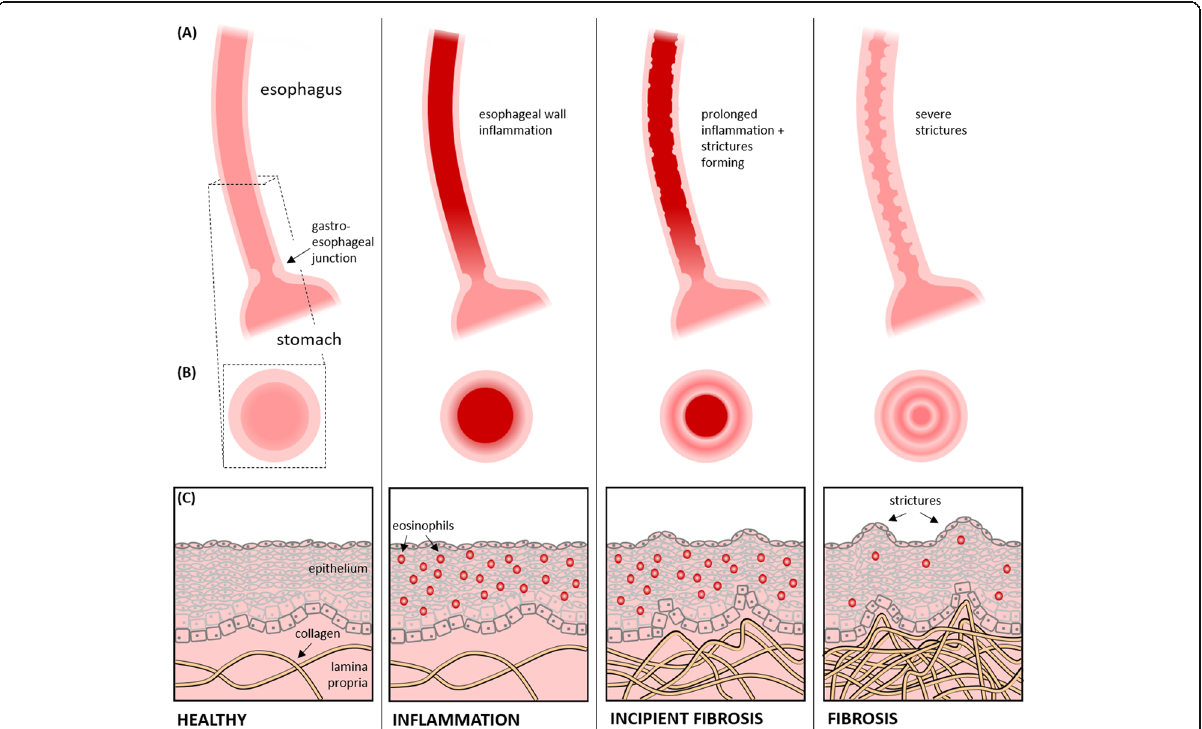
Fig. 1 Schematics illustrating the pathophysiologic natural progression of EoE from healthy, to acute eosinophil infiltration during an atopic reaction (redness and red spherical cells indicate inflammation), to incipient fibrosis after prolonged inflammatory conditions (arising strictures due to increased development of underlying fibrosis), to chronic fibrotic constrictions of the esophageal wall (severe strictures due to advanced fibrotic remodeling). a Anatomic representation of distal esophagus and proximal stomach. b Cross-sectional view of esophagus such as that provided by WLE. c Histologic section of relevant cellular linings – epithelium and lamina propria (figure following